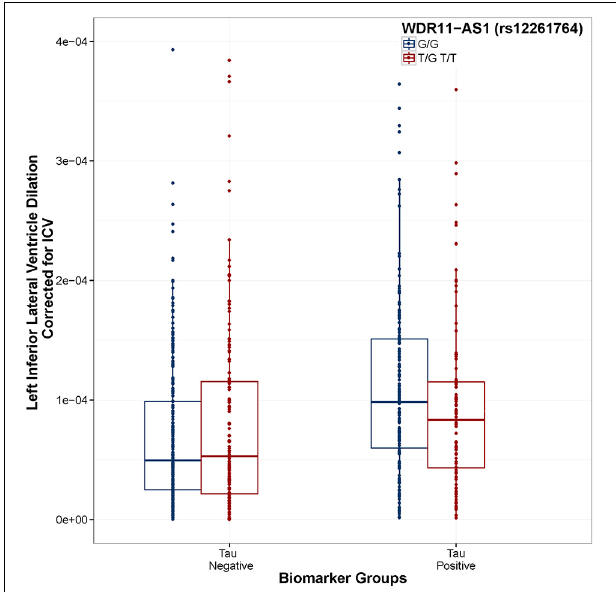
FIGURE 4 | WDR11-AS1 (rs12261764) modifies the association between Tau positivity and ventricular dilation. Biomarker groups are presented on the x-axis and annual change in the left inferior lateral ventricle is presented on the y-axis. Boxplots are grouped by rs12261764. G is the minor allele. When controlling for Age, Gender, Education, Diagnosis, and ICV, the tau_positive × rs12261764 interaction was statistically significant ( t = 5 . 55, p = 4.06 × 10 − 8 ). In the tau positive biomarker group, homozygous carriers of the G allele showed a greater rate of ventricular dilation than carriers of the T allele ( t = 2 . 18, p = 0 . 030). In the tau negative biomarker group, homozygous carriers of the G allele showed a slower rate of ventricular dilation than carriers of the T allele ( t = 2 . 21, p = 0 . 027). Model: LILV Slope = β 0 + β 1Baseline_Age + β 2 Baseline_ICV + β 3 Gender + β 4 Education + β 5Dx + β 6Tau_Positive + β 7Amyloid_Positive + β 8SNP + β 9SNP ∗ Amyloid_Positive + β 10SNP ∗ Tau_Positive